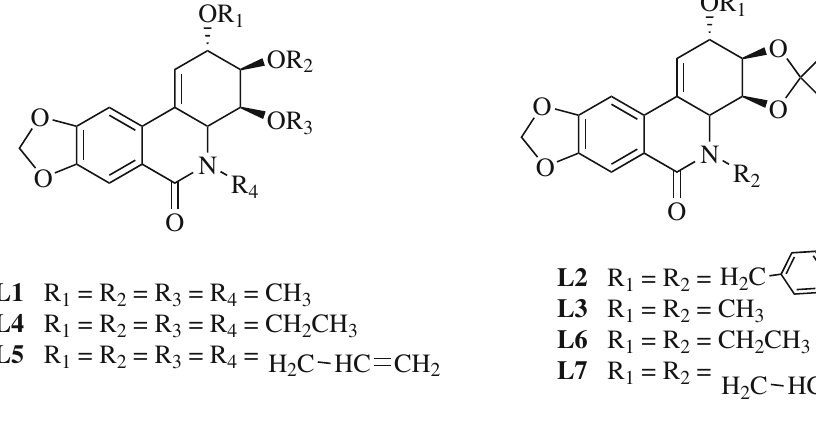
Table 1 Anti-TMV activities on N. glutinosa in